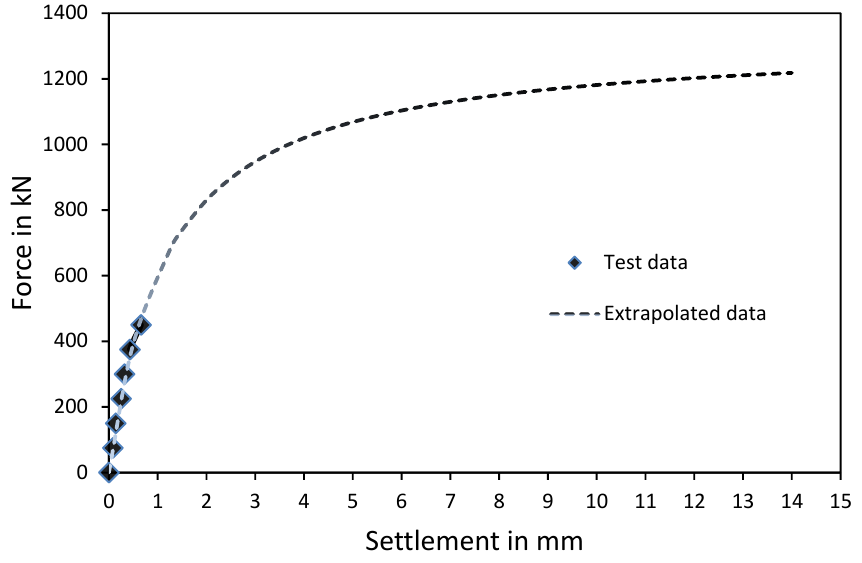
Figure 10. Load-settlement curve obtained from the micropile load test.